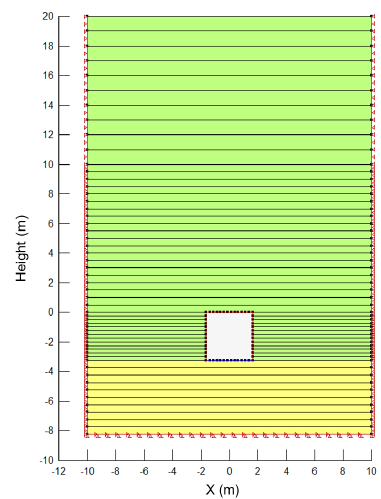
Figure 3. Layers of soil in the construction stages.